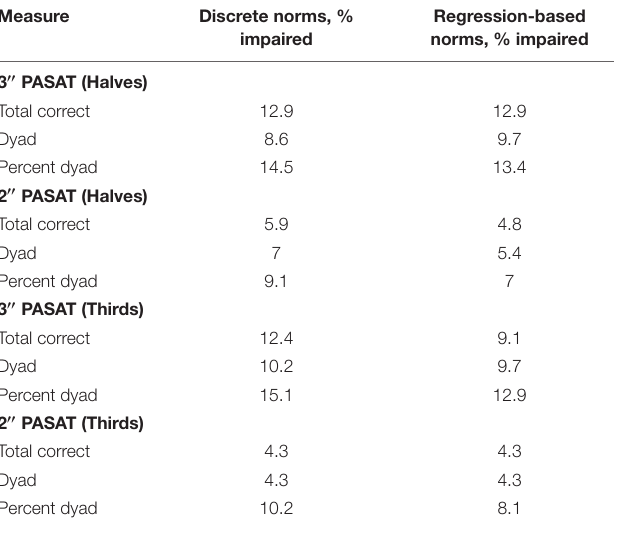
TABLE 5 | The proportion of the MS group impaired on PASAT cognitive fatigability measures. Measure Discrete norms, %